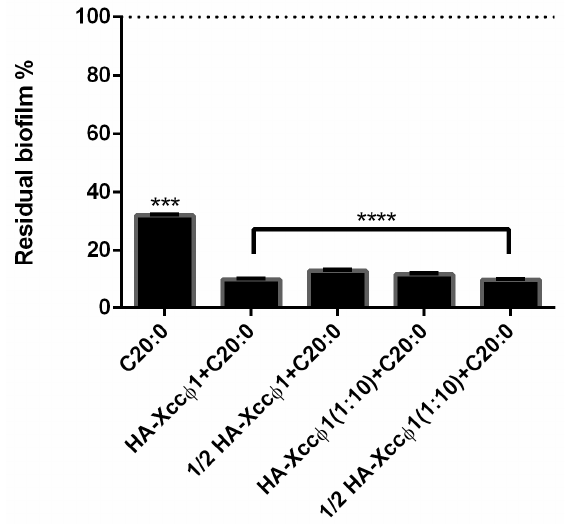
Figure 2. Analysis of the effect of C20:0 alone (30 µg/mL) or with Xcc φ 1 ( φ ) 10 8 /10 9 PFU/mL or Xcc φ 1 plus HA on Xcc biofilm structure using crystal violet assay after 72 h of incubation at 25 °C and 3 h of treatment. The data are reported as percentages of residual biofilm. Each value is the mean ± SD of three independent experiments. Statistical analysis was performed with the absorbance compared to the untreated control and considered statistically significant when p < 0.05 *** p < 0.001, **** p < 0.0001) according to two-way ANOVA multiple comparisons.